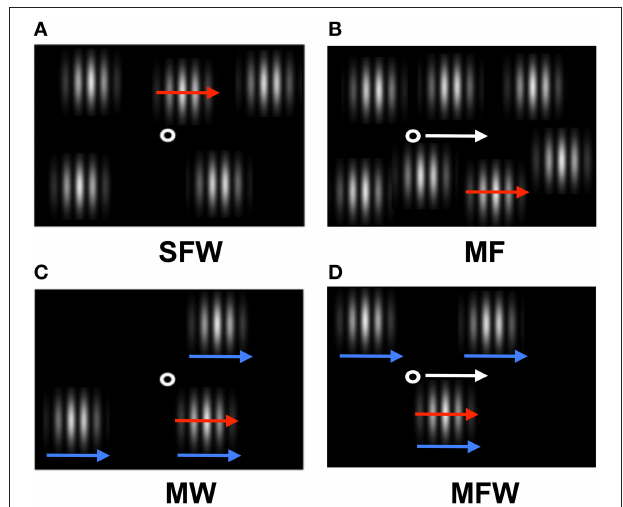
FIGURE 1 | Schematic of the stimulus display used in the experiment. Red arrows indicate target grating motion (which can be assigned to distracter gratings depending on experimental condition), white arrows indicate motion of the fixation point, and blue arrows indicate spatial windows motion (see Supplementary Materials). (A) Target grating drifts but fixation point and windows remain stationary (stationary fixation/window, SFW condition). This condition produces motion in all three coordinate systems (retinal, relative, and spatiotopic). (B) Target grating drifts while the observer tracks a fixation point moving together with the target grating (moving fixation, MF condition). In contrast to (A) , the target grating remains stationary on the retina and motion is present only in relative and spatiotopic coordinates. (C) The windows move together with the drifting target grating while the fixation point remains stationary (moving window, MW condition). In contrast to (A) , the relative motion between the target grating and windows is eliminated and motion is present only in retinal and spatiotopic coordinates. (D) Both the fixation point and the windows move together with the drifting grating while the observer tracks fixation (moving fixation/window, MFW condition). Here, motion exists only in the spatiotopic